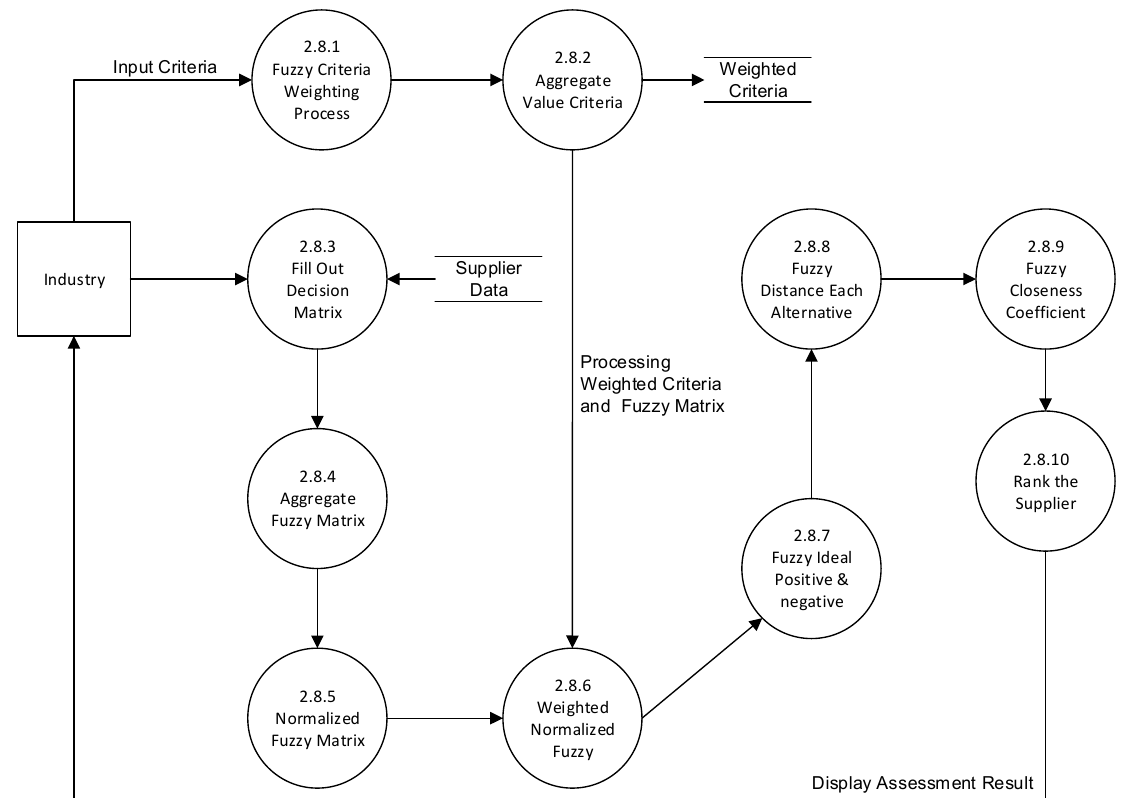
Figure 11. Diagram 2.8 level 3.